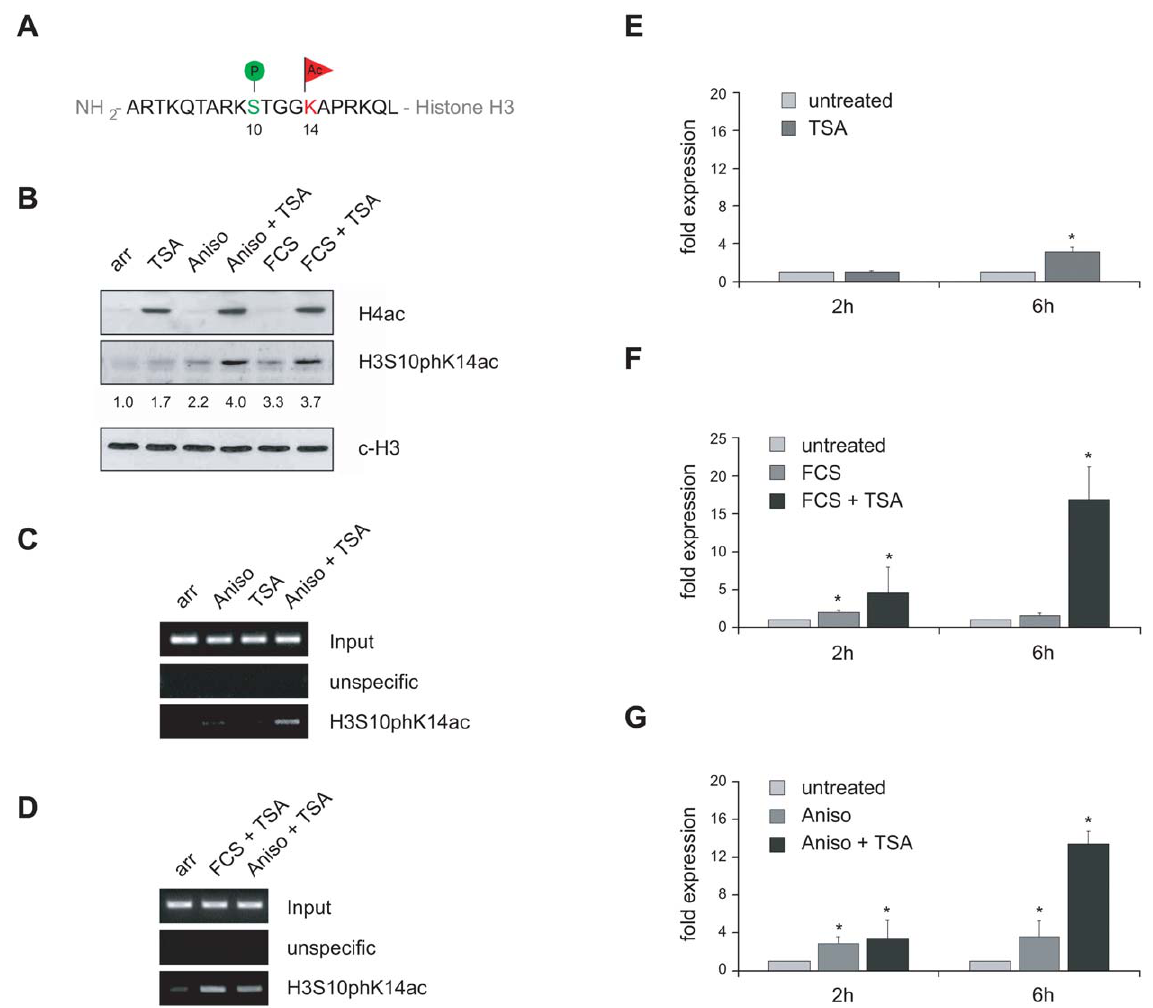
(H3S10ph) and acetylated lysine 14 (H3K14ac). (B) Phosphoacetylation of histone H3 in response activation of the MAP kinase pathway and TSA treatment in quiescent Swiss 3T3 fibroblasts. Serum deprived Swiss 3T3 fibroblasts were left untreated (arr) or treated for 2 hours with 166nM